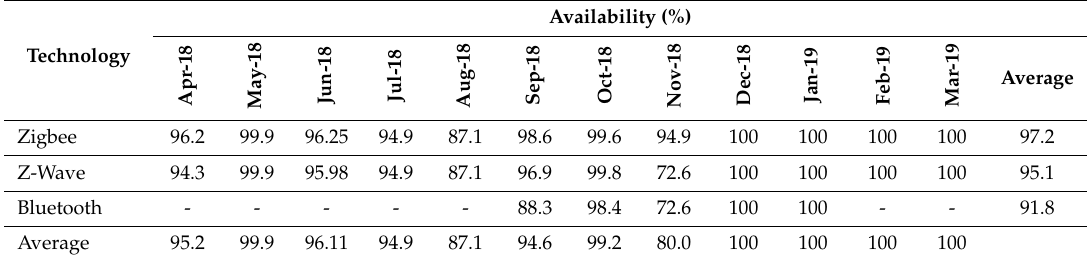
Table 2. Availability of each deployed technology in a one-year period